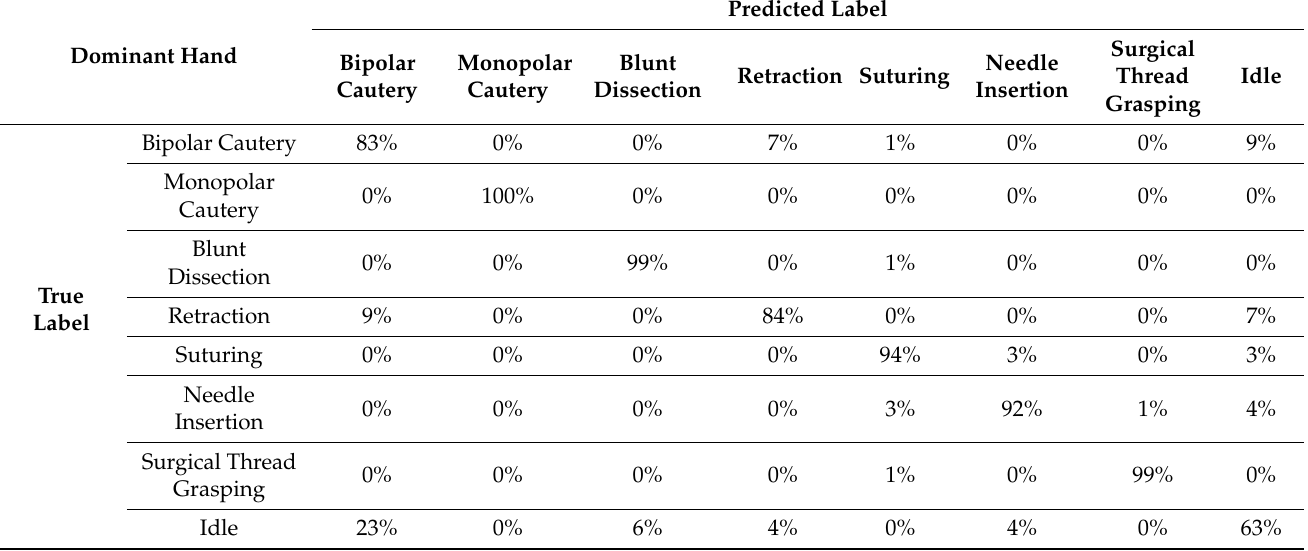
Table 6. Confusion matrix for classification of eight surgical gestures performed by dominant hand.